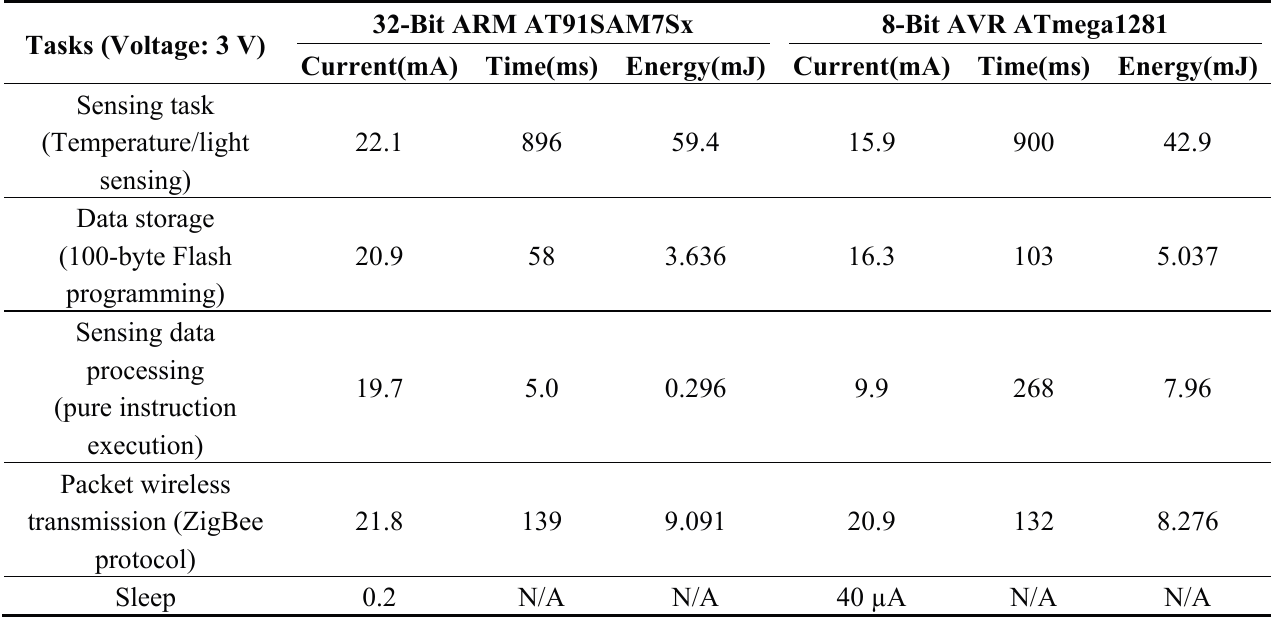
Table 4. Energy consumed by executing different tasks on different